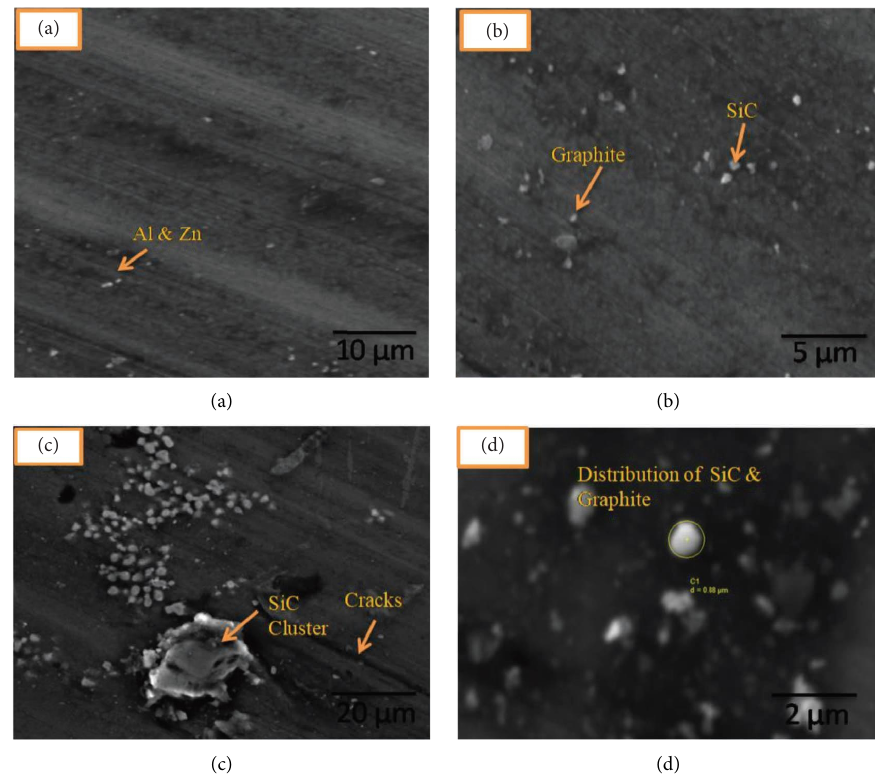
Figure 3: SEM images of (a) AZ31, (b) A31-3 wt. % SiC/Gr, (c) AZ31-5 wt. % SiC/Gr, and (d) AZ31-7 wt. % SiC/Gr.